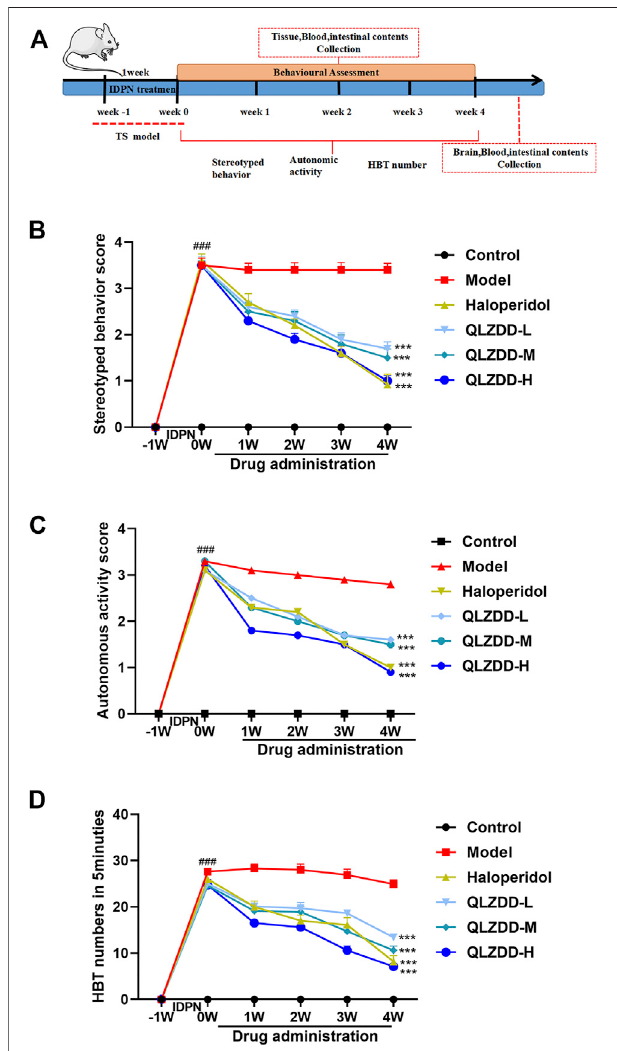
FIGURE 2 | The effect of QLZDD on the tic-like behavior. (A) Time fl ow chart. (B) The stereotyped behavior score of the QLZDD groups and the stereotyped behavior score of the haloperidol group were signi fi cantly lower than that of the model group. (C) The autonomic activity behavior score of the QLZDD groups and the autonomic activity behavior score of the haloperidol group were signi fi cantly lower than that of the model group. (D) The HBT number of the QLZDD groups and the HBT number of the haloperidol group were signi fi cantly lower than that of the model group. All data were expressed as mean ± SD ( n = 15 mice). The data of the QLZDD groups and the haloperidol group were analyzed by repeated measures ANOVA and were compared to the data of the control